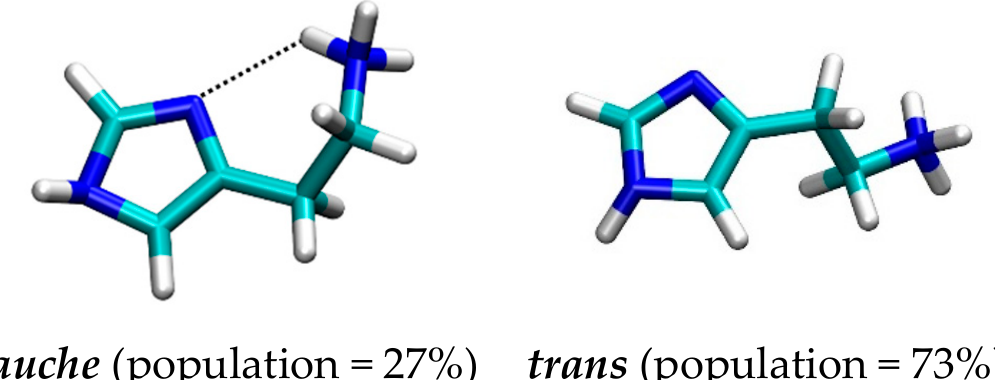
Figure 3. Representative conformations with their population of the histamine monocation in aqueous solution as obtained by the molecular dynamics simulation.